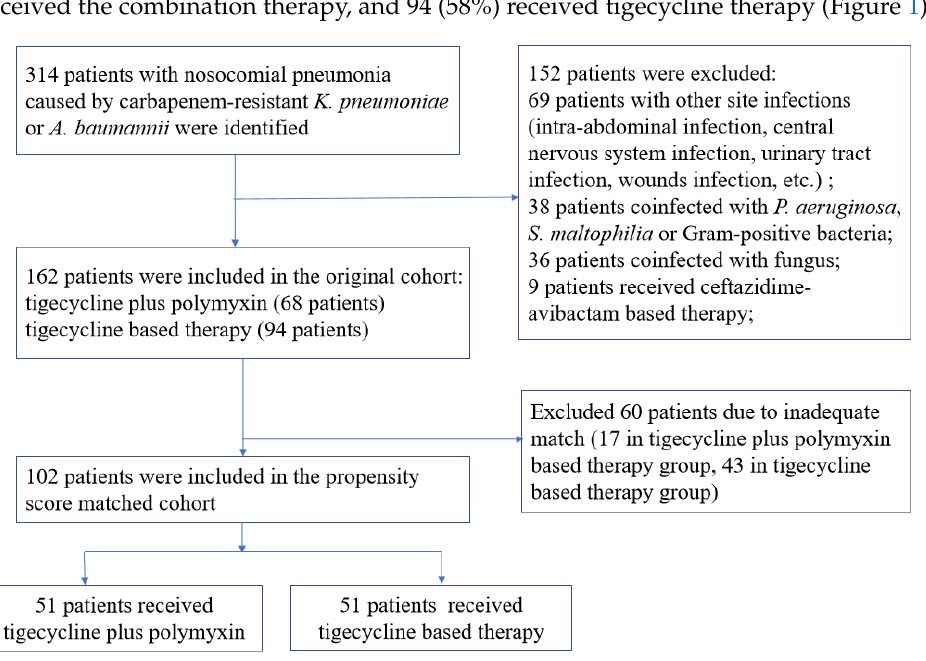
Figure 2. The covariate balance in the two groups before and after the propensity score matching. Red dots and blue triangles indicated the absolute standardized mean differences ( left ) and the Kolmogorov–Smirnov statistics ( right ) of the covariate in the original and the matched cohort, re- spectively. SOFA, Sequential Organ Failure Assessment; IIAT, Inappropriate Initial Antibiotic Ther- apy; CCI score, the age-adjusted Charlson comorbidity index. 3.2. Characteristics of Patients in the Matched Cohort The median age of patients in the matched cohort was 60 (IQR 51.25 – 76) years, and 69.6% were male. Most patients reported comorbidities, with an age-adjusted Charlson comorbidity index score of four (IQR 2 – 6). In the matched cohort, apart from 19 patients having malignancy, no other high-risk patients were included (e.g., patients suffering from cystic fibrosis, infected with human immunodeficiency virus, or having received an organ transplantation). A total of 63 (61.8%) patients were diagnosed with VAP, and 49 (38.2%) were diagnosed with HAP. Among the included patients, 70.6% (72) were infected with A. baumannii , 29.6% (30) were with K. pneumoniae , and 9.8% (10) of them were polymi- crobial pneumonia. The distribution of MICs of tigecycline and polymyxin B in A.